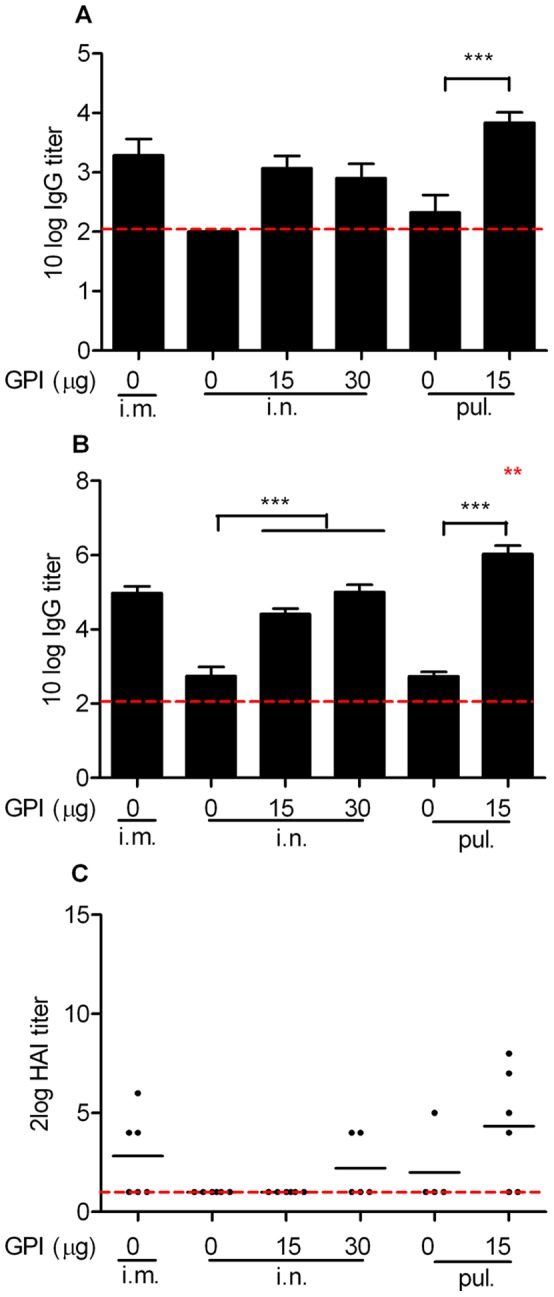
Influenza-specific IgG and hemagluttination inhibition (HAI) titers elicited by unadjuvanted and GPI-0100-adjuvanted mucosal influenza vaccine.Serum samples from the mice described in the legend to Fig. 1 were collected on day 20 and day 34. (A) Total IgG responses after a single immunization. Average 10log IgG titers ± standard error of the mean (S.E.M.), n  = 6 mice per group. The detection limit of the assay is represented by the dotted line. (B) Total IgG responses after two immunizations. (C) HAI titers after two immunizations. The results are expressed as 2log HAI titers of individual mice. The black line represents the geometric mean virus titer per group. Due to technical reasons only 5 and 4 samples from mice receiving 30 µg GPI-0100 adjuvanted intranasal immunization and unadjuvanted intrapulmonary immunization were available for the HAI assay.